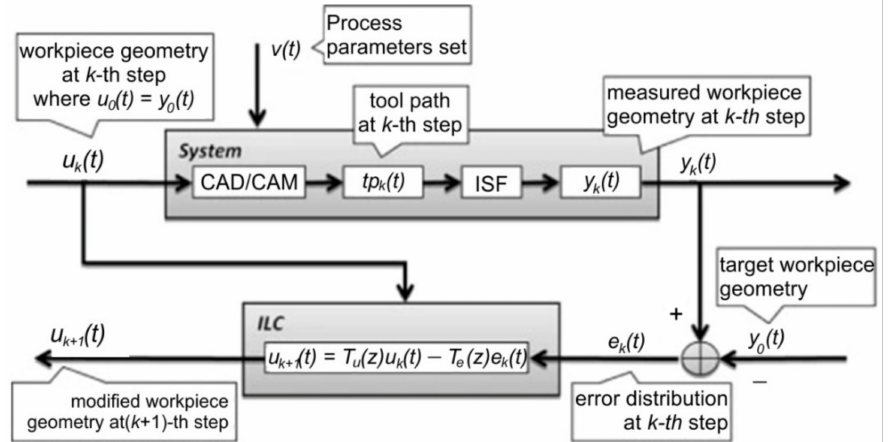
Figure 20. The algorithm used for increasing part accuracy: u k (t) —part geometry, u k+1 (t) —part geometry (corrected), v k (t) —process parameters set, tp k (t) —toolpath, y k (t) —obtained geometry, y d (t) —target geometry, e k (t) —error map and T e (z) —correction weight (reprinted with permission from [120]; copyright © 2016, Springer-Verlag